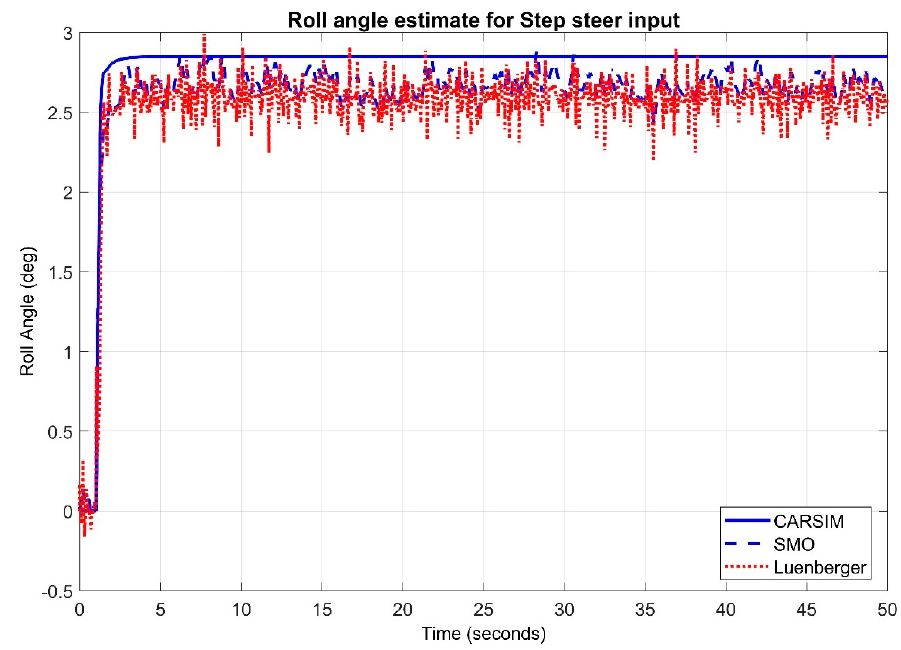
Figure 14. Observer Results for Step input with Gaussian noise.